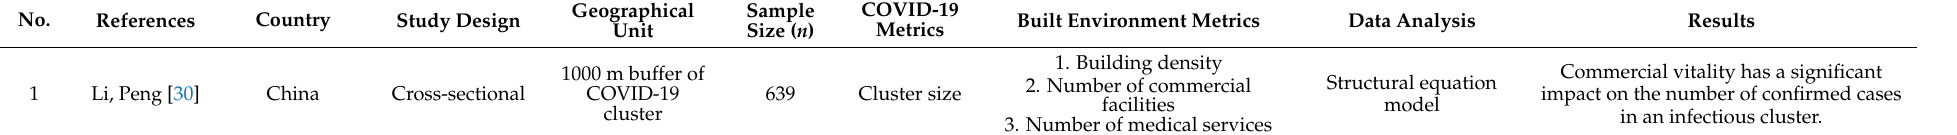
Table A1. Summary of study sample characteristics, study design, built environmental metrics, COVID-19 metrics, data analysis method, and